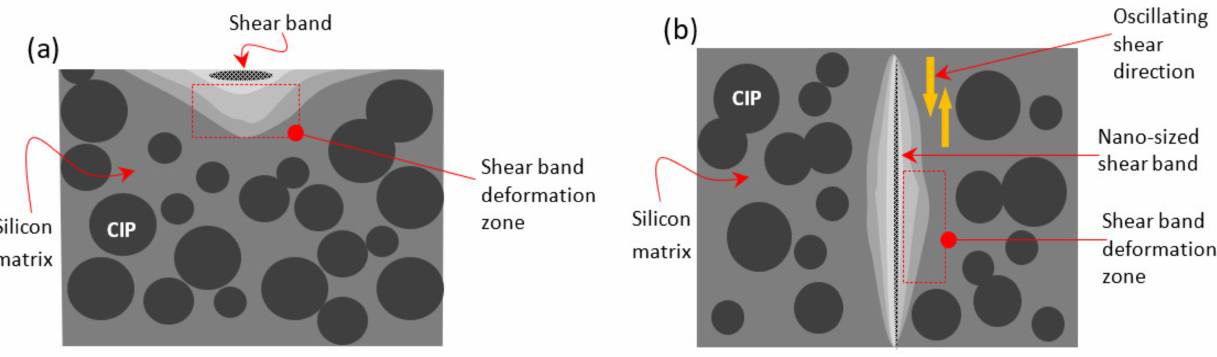
Figure 4. Schematic of the SBDZ developed from the localized microplasticity ( a ) cross-sectioned view and ( b ) top-view, as obtained from oscillated shearing of stress relaxation durability